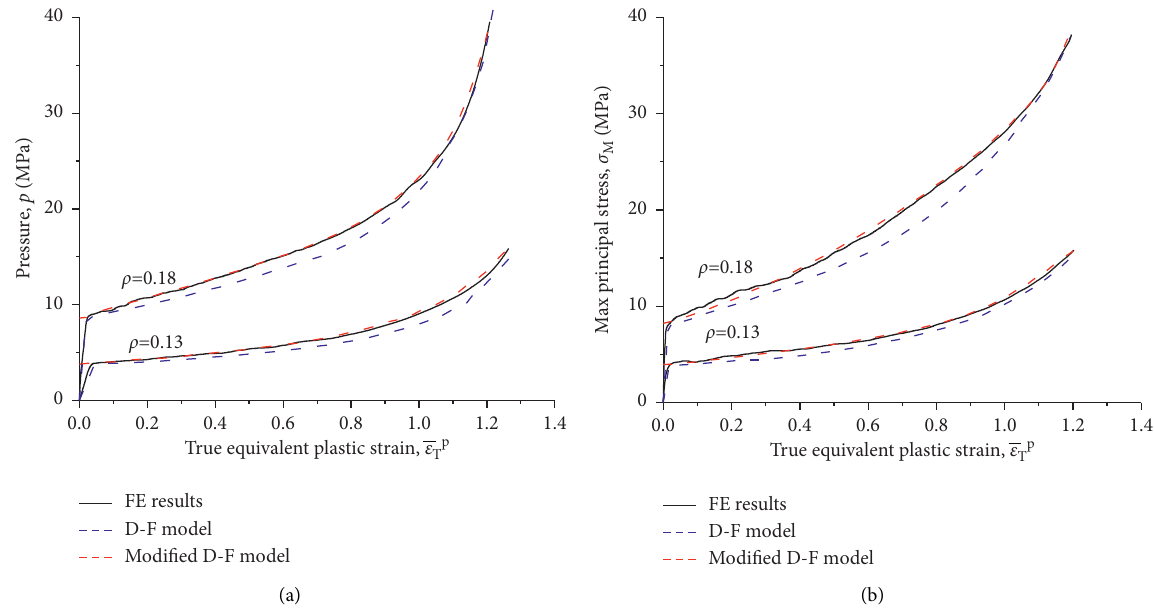
Figure 15: Predictions of triaxial loading conditions by the D-F model and the modified D-F model when the velocity ratio of three principal stress directions is (a)1:1:1 and (b)2: